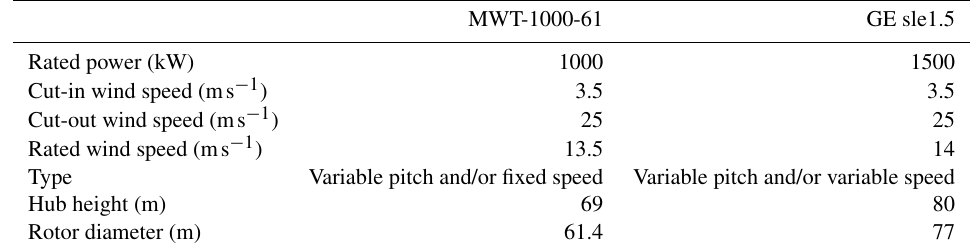
Variable pitch and/or variable speed